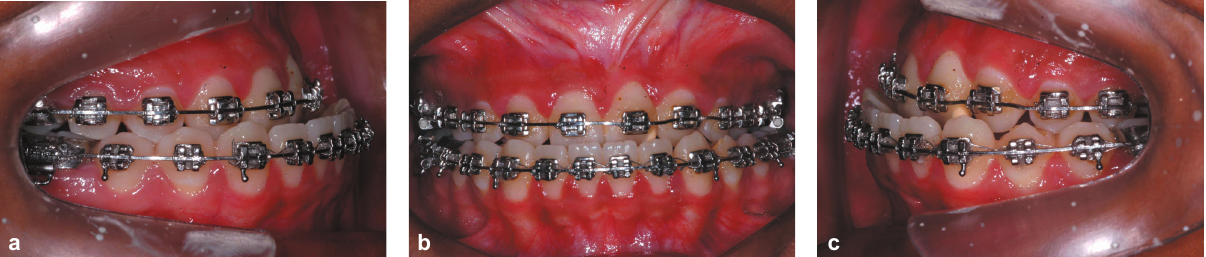
Figure 9- Preoperative intraoral photographs (a) right occlusion view, (b) frontal view, (c) left